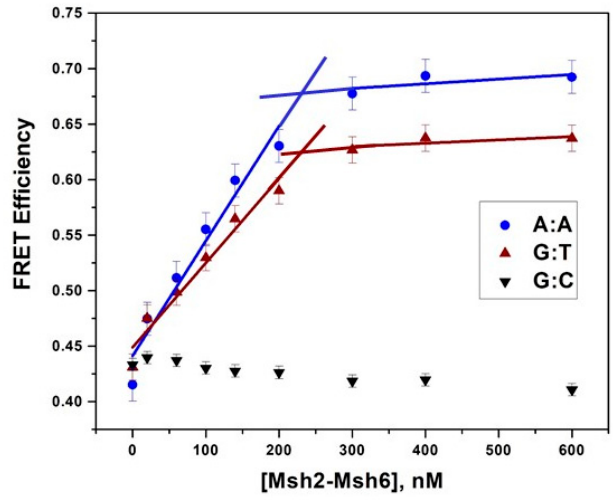
Figure 6. Steady-state Förster Resonance Energy Transfer (FRET) efficiency change upon Msh2–Msh6 binding for A:A and G:T duplex DNA is indicative of protein-induced bending and yields a 1:1 binding stoichiometry. A 200 nM concentration of either A:A, G:T mismatched or G:C homoduplex